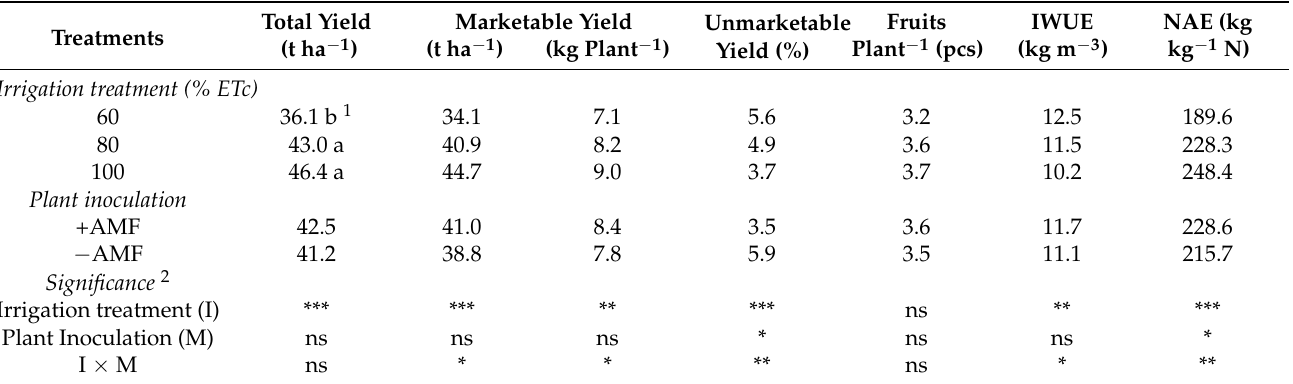
Table 3. Effect of irrigation treatments and plant inoculation with arbuscular mycorrhizal fungi (AMF) on yield components, irrigation water use efficiency (IWUE), and nitrogen applied efficiency (NAE) of melon plants during two years of